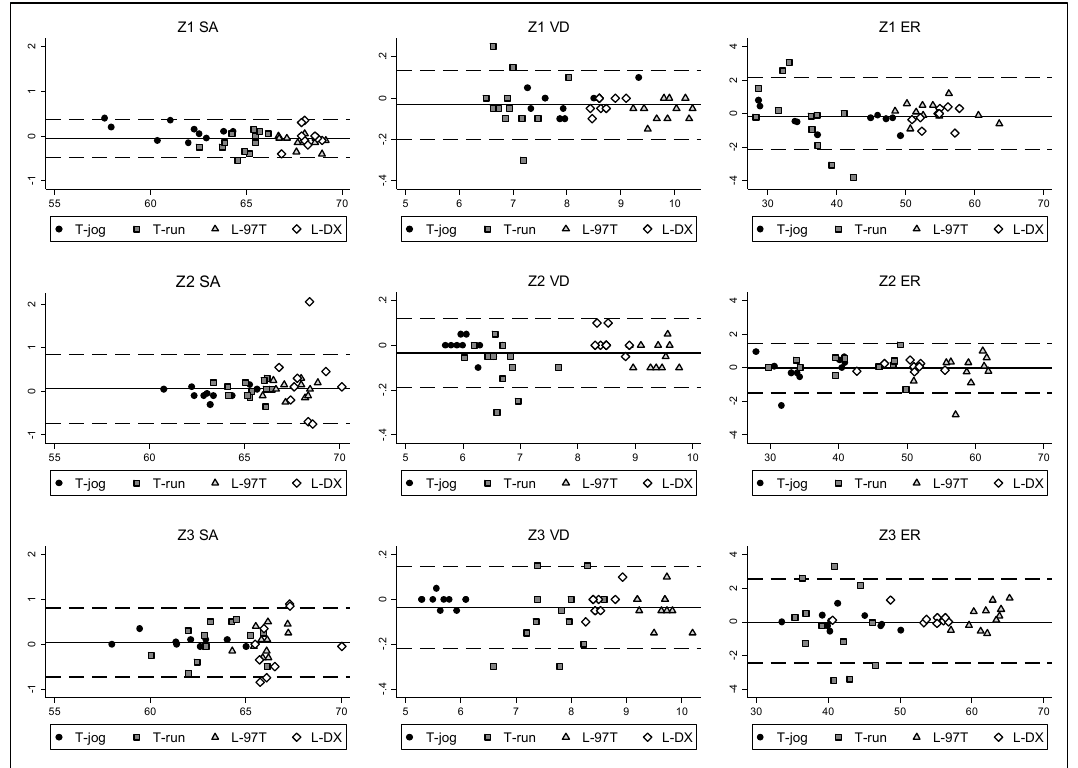
Figure 3. Bland–Altman analysis of the agreement between R1 and MeanR2R3. The y -axis represents the mean di ff erence (R1 minus MeanR2R3) and the x -axis represent the average of SA (%), VD (mm), and ER (%). T-jog, T-run, L-97T, L-DX are the di ff erent treadmill models.